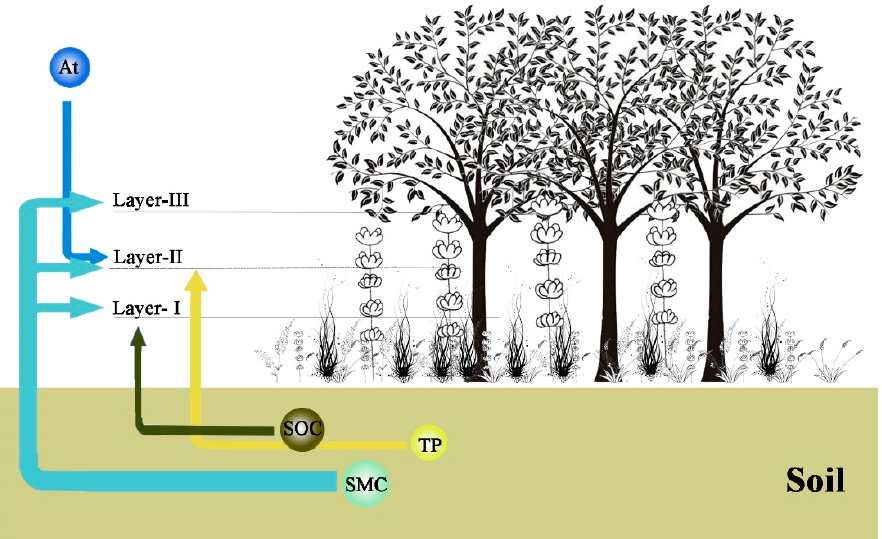
Figure 6. Understory stratification and main influence factors in black locust plantations of Loess Plateau.